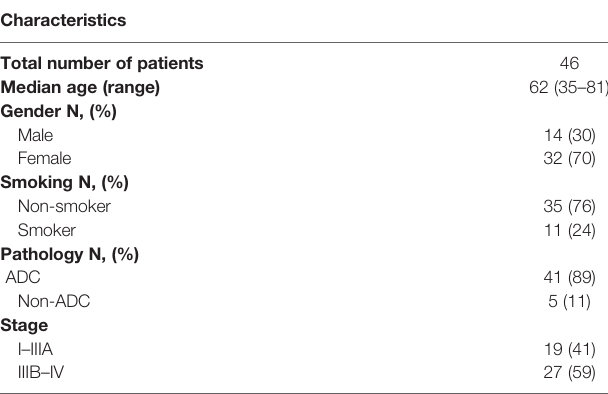
TABLE 2 | The demographic and clinico-pathological characteristics of patients harboring co-occurring potentially actionable targets.